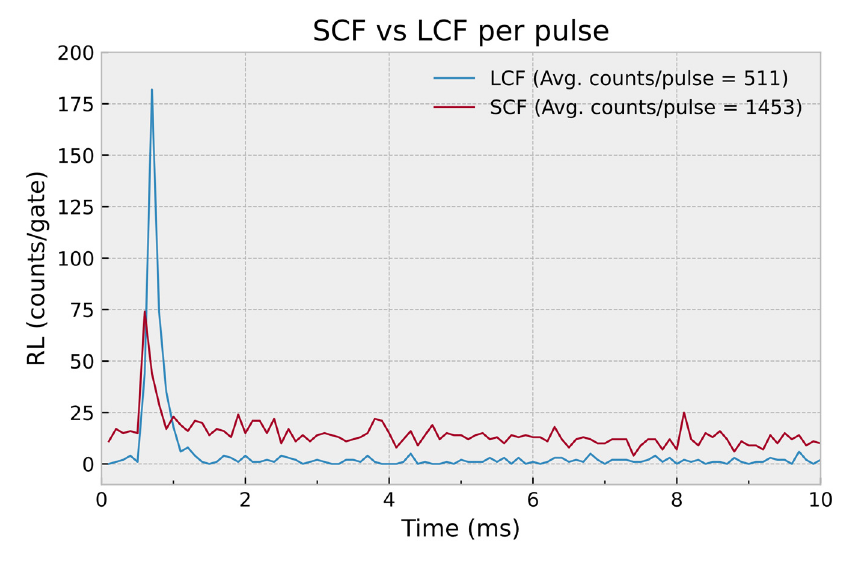
Figure 9. Comparison of the traces of the RL response (gate time of 100 μ s) from a single pulse for the SCF and LCF obtained at dose rates of 140 MU/min (10 ms interval between adjacent pulses).